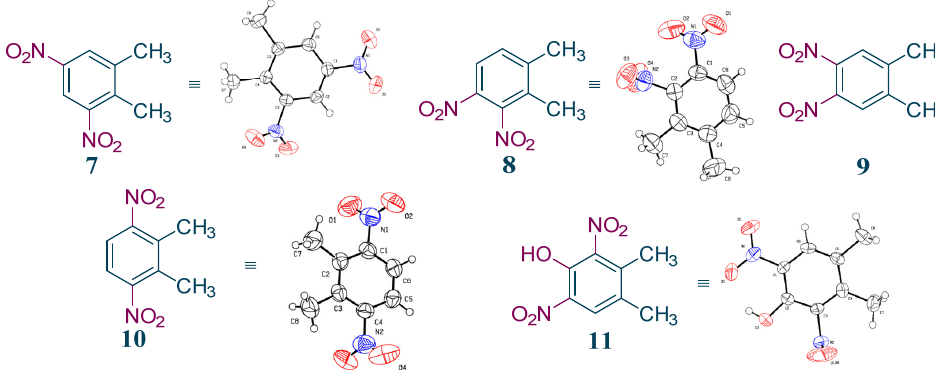
Figure 6. The structures of the main impurities in o -xylene nitration process.